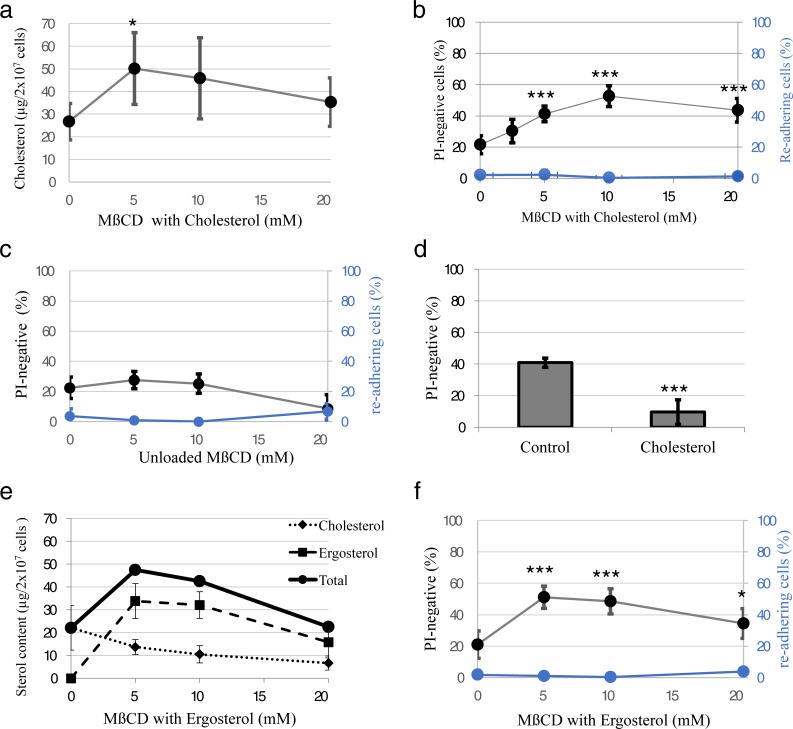
Effects of sterol-loading on HeLa cells after cryopreservation.a) HeLa cells have been enriched with cholesterol by treating them with 0–20 mM methyl-β-cyclodextrin (MβCD) with cholesterol for 60 min. Afterwards their cholesterol content has been measured fluorometrically using enzyme-coupled reactions to produce fluorescent resorufin. n = 3; *: p<0.05 vs 0 mM using student´s t-test b) HeLa cells treated with 0–20 mM MβCD with cholesterol for 60 min have been rapidly frozen without cryoprotectants in open pulled straws (OPS) in liquid nitrogen. After thawing in cell culture medium at 37°C, the plasma membrane integrity of the cells has been tested by propidium iodide (PI) staining (black circles; left y-axis; n = 4–6) and the ability of cells to re-adhere has been tested (blue circles; right y-axis; n = 12). ***: p<0.001 vs 0 mM using student´s t-test c) HeLa cells treated with 0–20 mM unloaded MβCD for 60 min have been rapidly frozen without cryoprotectants in OPS in liquid nitrogen. After thawing in cell culture medium at 37°C, the plasma membrane integrity of the cells has been tested by propidium iodide (PI) staining (black circles; left y-axis; n = 4–6) and the ability of cells to re-adhere has been tested (blue circles; right y-axis; n = 3–5). d) HeLa cells treated with 10 mM MβCD with cholesterol for 60 min (Cholesterol) and untreated control cells have been slowly frozen without cryoprotectants with 1°C/min. After thawing in cell culture medium at 37°C, the plasma membrane integrity of the cells has been tested by PI staining. n = 6; ***: p<0.001 vs control using student´s t-test e) HeLa cells have been enriched with ergosterol by treating them with 0–20 mM ergosterol-loaded MβCD for 60 min. Afterwards their cholesterol content has been measured fluorometrically using enzyme-coupled reactions to produce fluorescent resorufin and their ergosterol content has been measured spectroscopically. Total sterol content is depicted as the sum of the mean values of ergosterol and cholesterol content. n = 3 f) HeLa cells treated with 0–20 mM MβCD with ergosterol for 60 min have been rapidly frozen without cryoprotectants in OPS in liquid nitrogen. After thawing in cell culture medium at 37°C, the plasma membrane integrity of the cells has been tested by propidium iodide (PI) staining (black circles; left y-axis; n = 4–6) and the ability of cells to re-adhere has been tested (blue circles; right y-axis; n = 3–4). *: p<0.05, ***: p<0.001 vs 0 mM using student´s t-test.